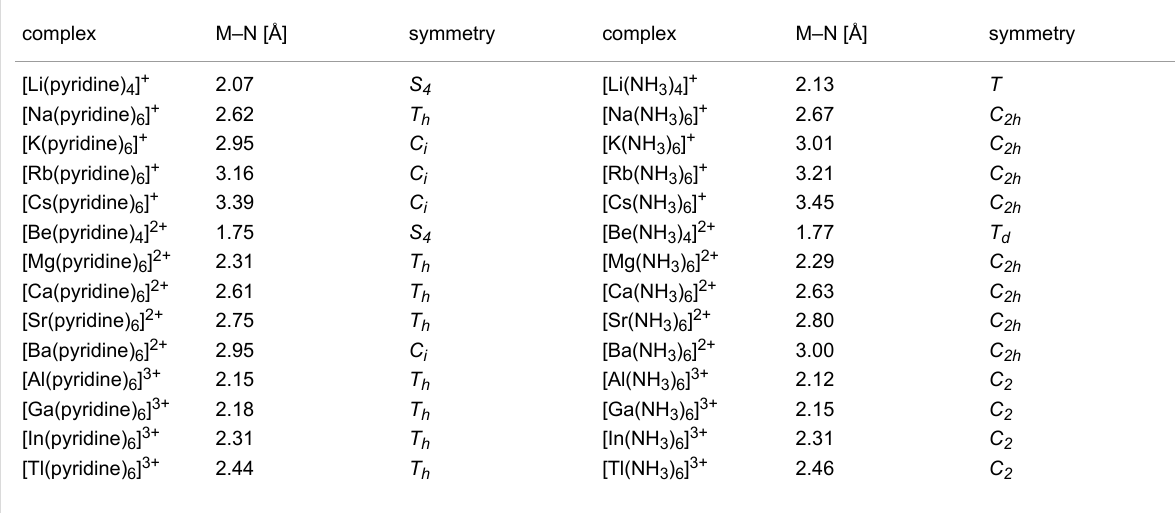
Table 5: Calculated distances (in Å) of the metal–donor interactions in [M(pyridine) n ] m+ and [M(NH 3 ) n ] m+ .